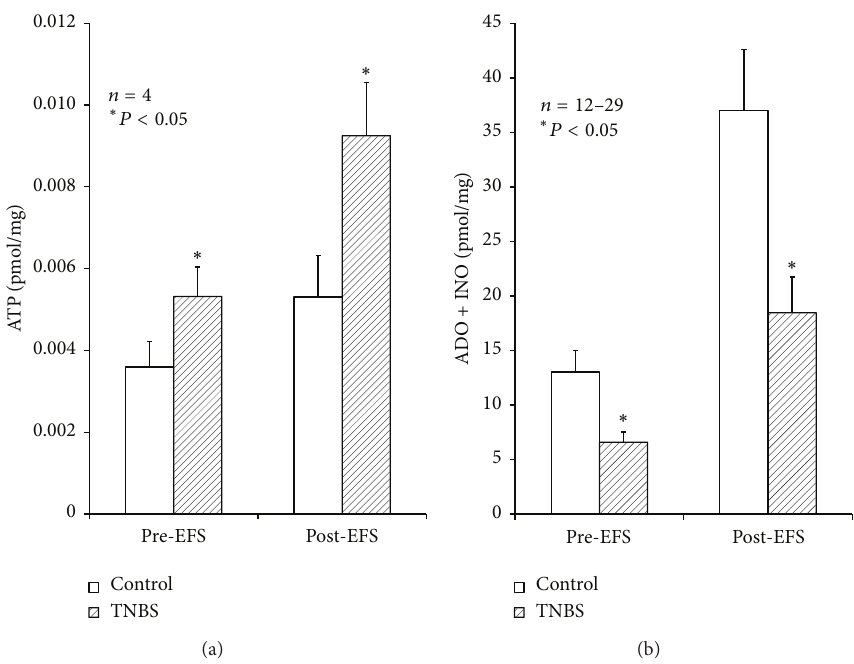
Figure 3: Effect of electrical field stimulation (EFS) on extracellular accumulation of purines in the LM-MP of control and inflamed rat ileum. The preparations were incubated with Tyrode’s solution for 15min and then subject to EFS (5 Hz frequency, 3000 pulses of 1ms duration). Samples collected from the incubation media were analysed by HPLC to separate and quantify purine nucleosides; ATP outflow was assessed using the luciferin-luciferase bioluminescence assay. Illustrated are ATP (a) and purine nucleosides (b) content of bath samples collected immediately before (Pre-EFS) and after (Post-EFS) LM-MP stimulation expressed in pmol/mg of tissue. Data are means ± SEM of an 𝑛 number of individual experiments. ∗ 𝑃 < 0.05 (one-way ANOVA followed by Dunnett’s modified t -test) represent significant differences as compared to control